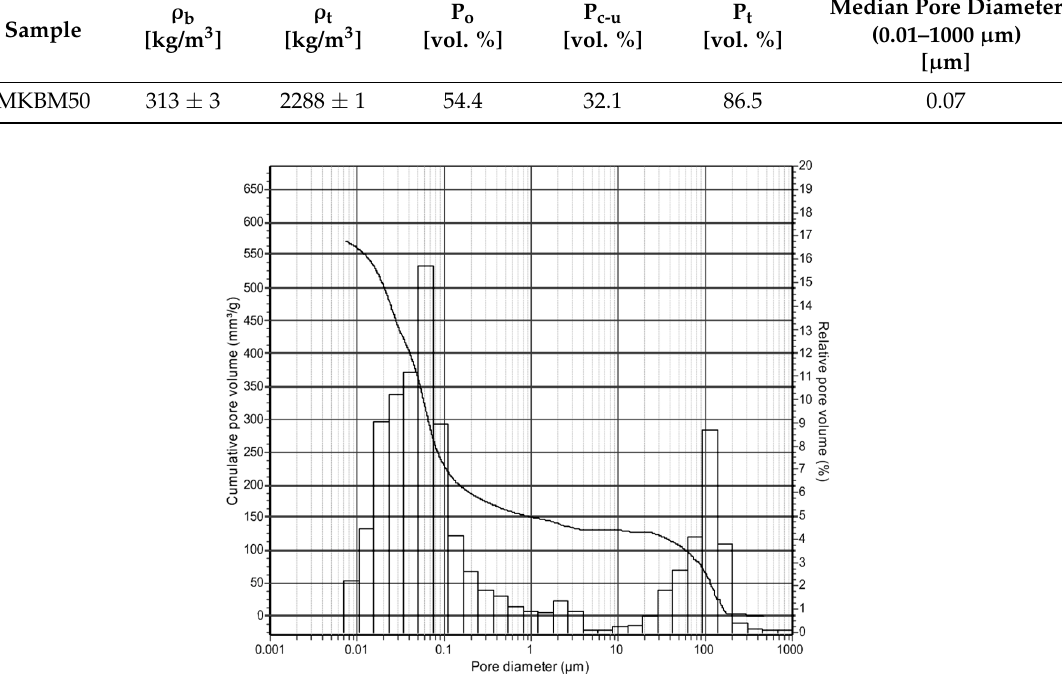
Table 4. Density, porosity and average pore diameter for MKBM50.